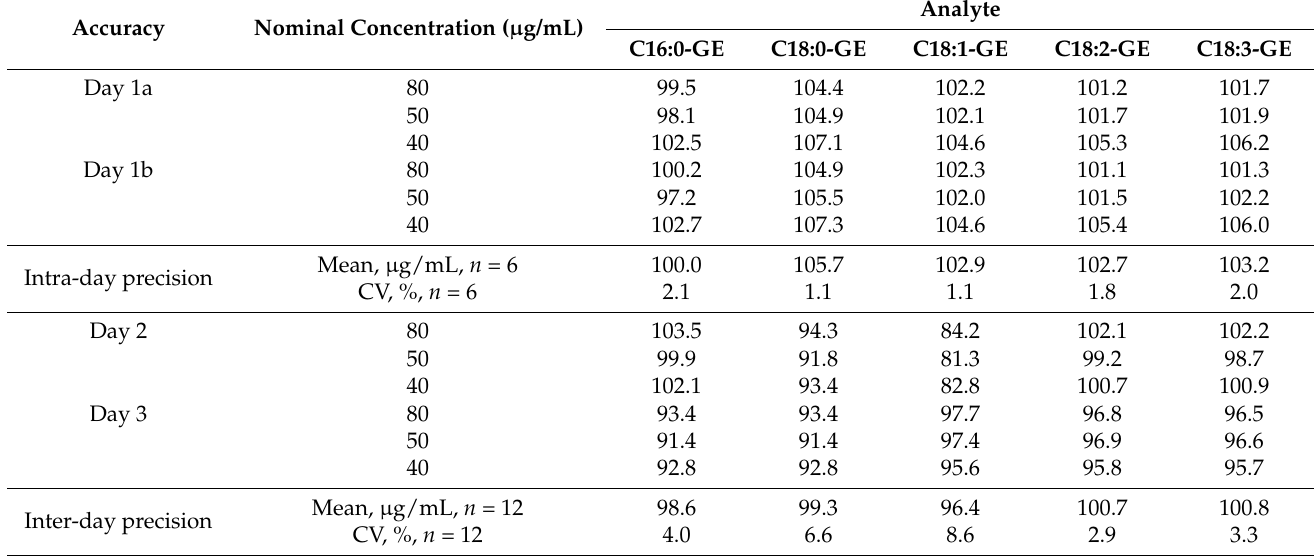
Table 4. Inter-day and intra-day precision and accuracy data of five glycidyl ester (GE) species in